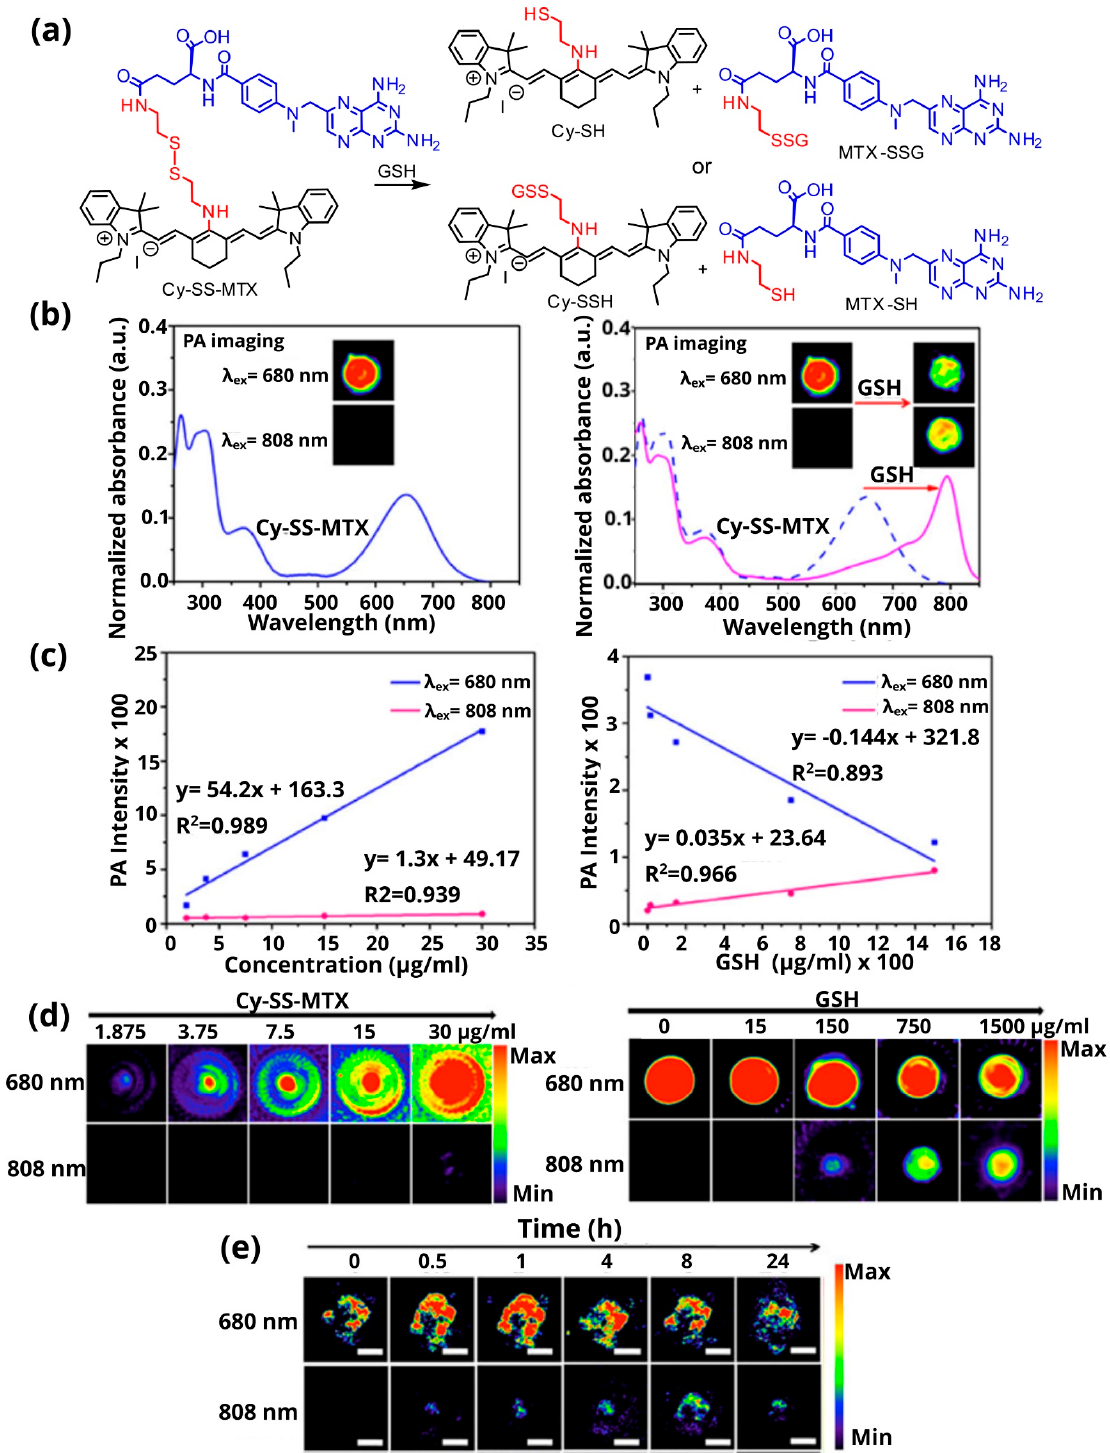
Figure 8. ( a ) Schematic representation of the mechanism of action of Cy-SS-MTX theranostic agent in the presence of glutathione (GSH); ( b ) presentation of the positive increase in photoacoustic signal of Cy-SS-MTX in the presence of GSH; ( c ) PA intensity of Cy-SS-MTX and responses of Cy-SS-MTX to GSH upon excitation at 680 and 808 nm, respectively, in varying concentrations; ( d ) the corresponding illustrations of PAI; and ( e ) in vivo photoacoustic imaging of tumor-bearing mice at 0/0.5/1/4/8/24 h after intravenous injection. Adapted from [115], Frontiers in Materials,